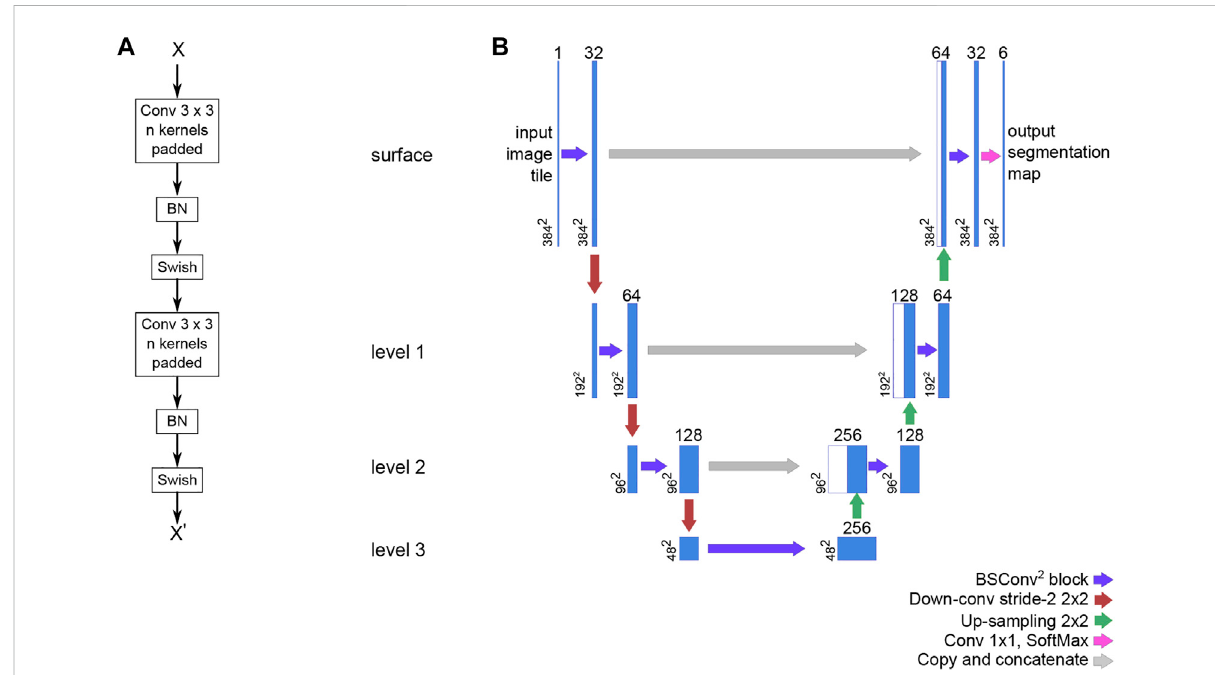
FIGURE 4 ThebasicbuildingblockofourU-Netvariantandtheoverallnetworkarchitecture. (A) TheBSConv2blockconsistsoftworepeatsofare fl ection padded 3 × 3 convolution and linear activation followed by batch normalization and a trainable Swish activation (B) The U-Net architecture is structured into levels that share operation parameters. For a U-net with a depth of three, there are three levels below the surface level (depth 0). For each subsequent level, the number of fi lters per convolution is doubled and the spatial dimensions are halved.